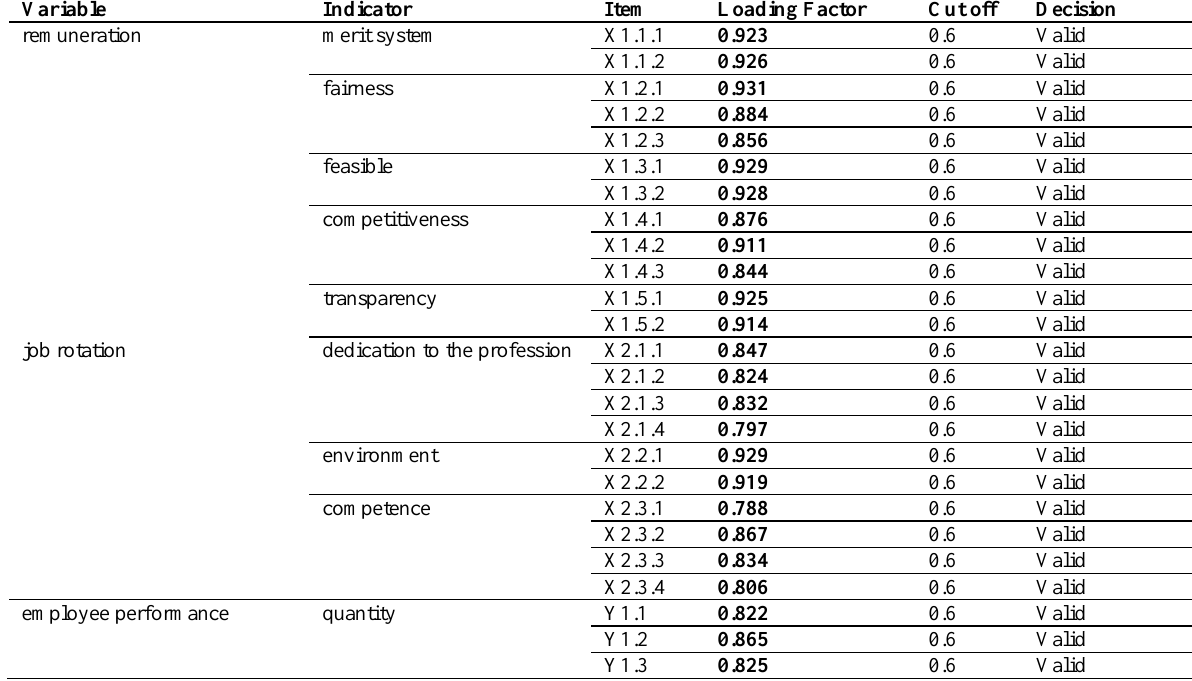
Table 2: Results of Convergent Validity and Discriminant